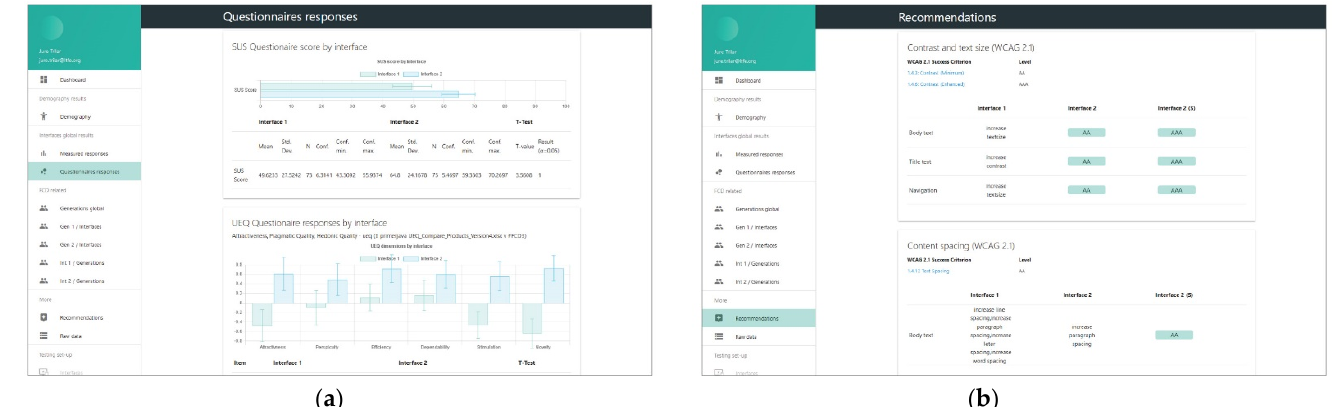
Figure 5. Backend administration displaying ( a ) user evaluation results, and ( b ) WCAG 2.1. recommendation tool.